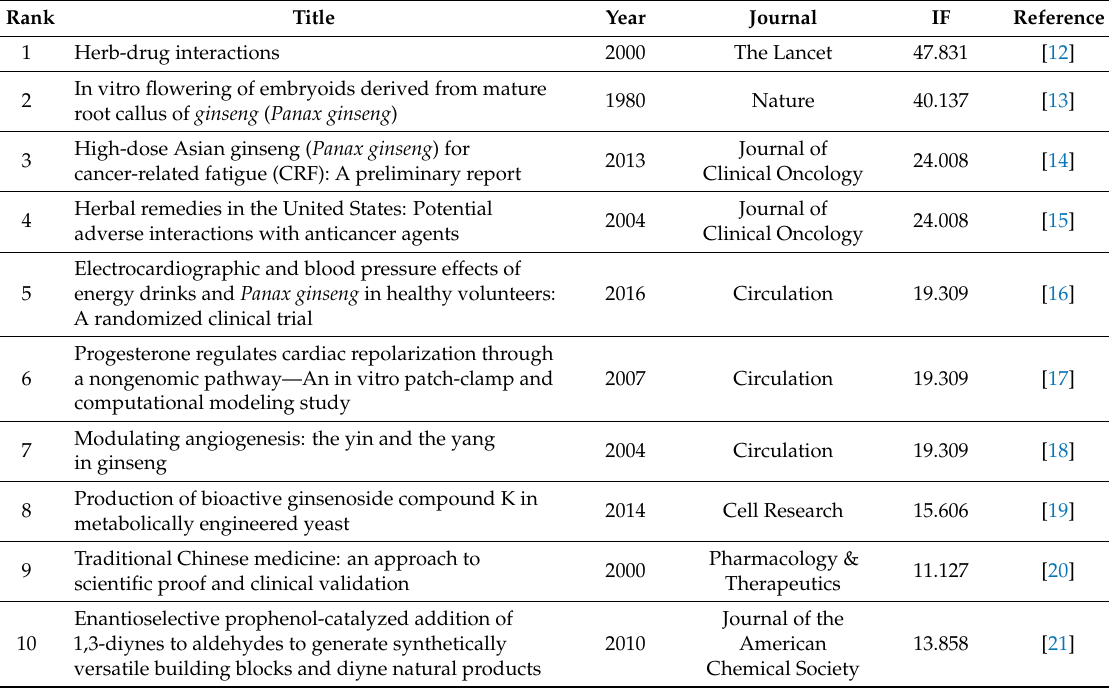
Table 4. Top 10 articles with the highest